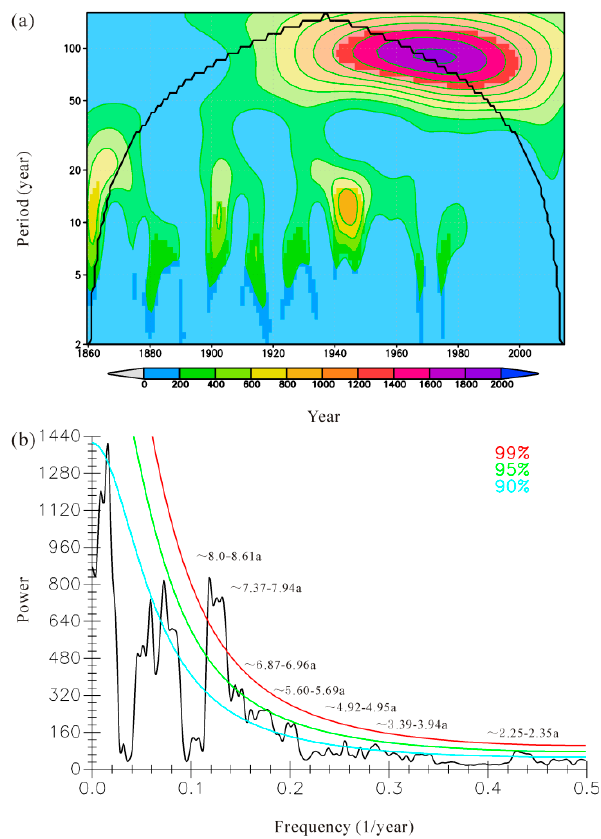
Figure 6. Cycle results of ( a ) Paul wavelet with a parameter value of 4 [29] and ( b ) multitaper spectrum (MTM) analyses [28] for reconstructed January–September mean self-calibrating Palmer Drought Severity Index for the period of 1859–2014. The cone of influence in the wavelet analysis is indicated by the black line. The confidence intervals at 99%, 95%, and 90% for peaks in the power spectrum are indicated by the red, green, and blue lines, respectively.